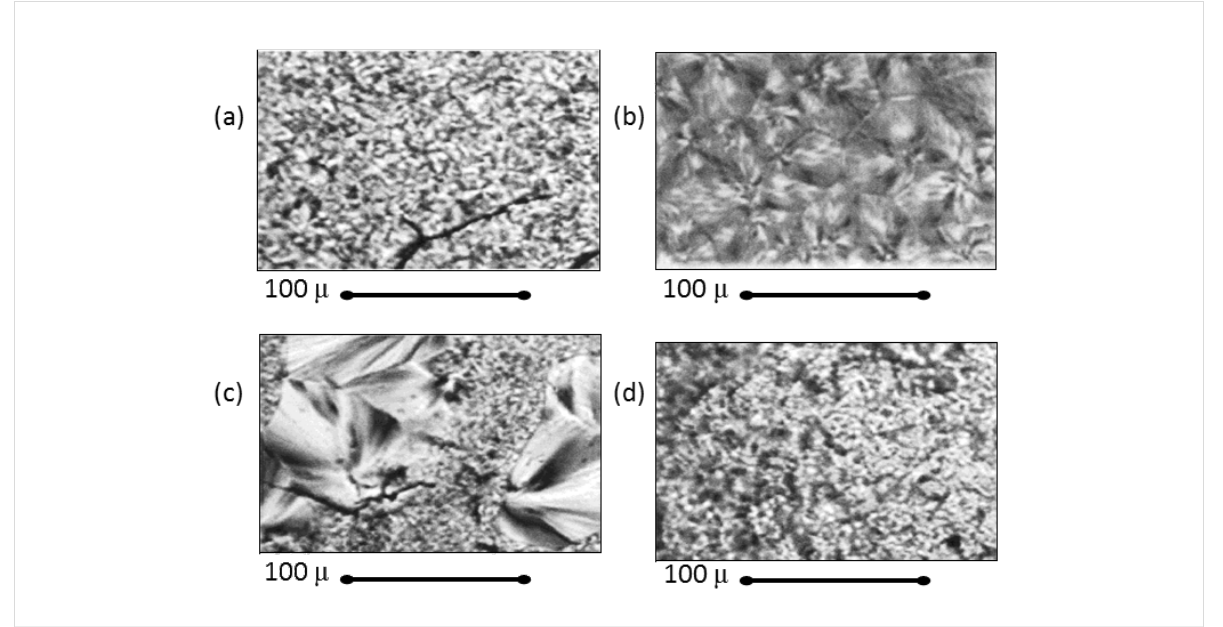
Figure 7: Polarizing photomicrographs of (a) PLLA, (b) PCL, (c) solution-cast, and (d) coalesced PLLA/PCL blends [8].